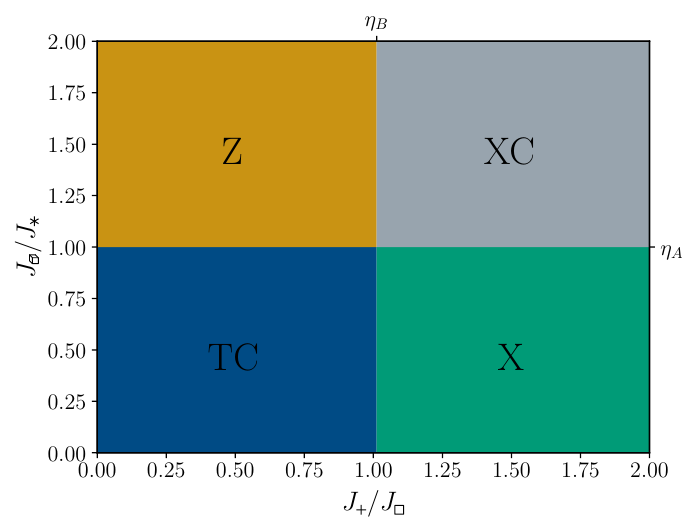
Figure 3: Ground-state phase diagram of and horizontal lines correspond to η phase are displayed in blue and gray, whereas the X- and Z-phases are shown in green and brown, respectively.